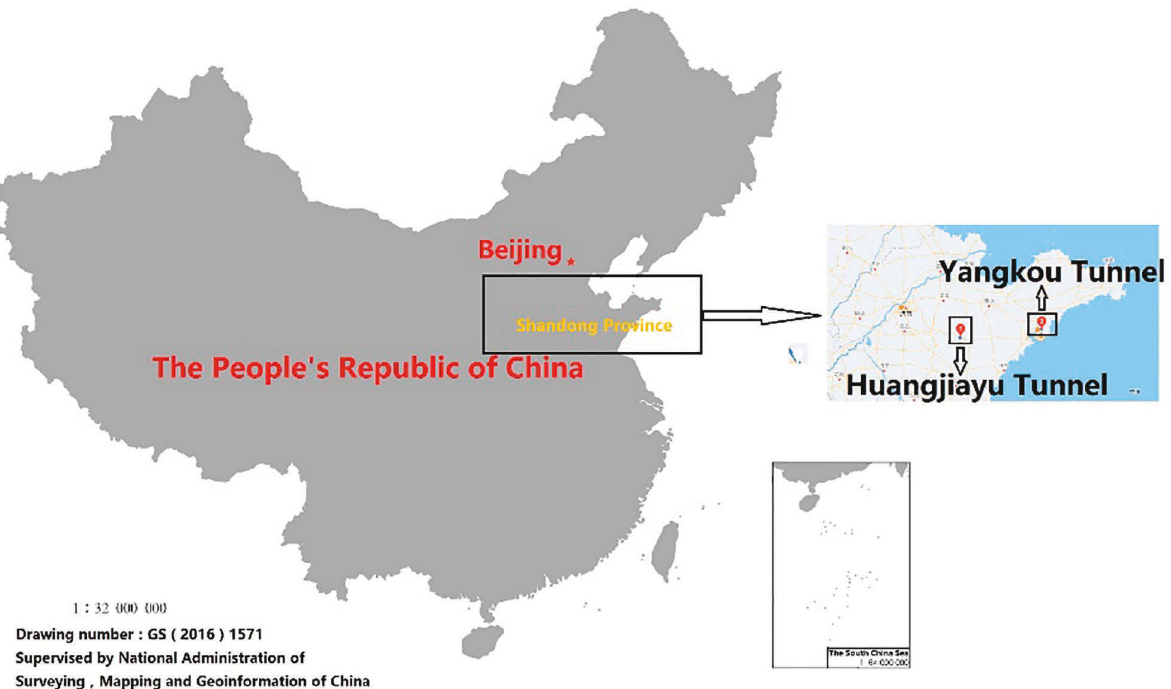
Figure 3: Location of Yangkou tunnel and Huangjiayu tunnel